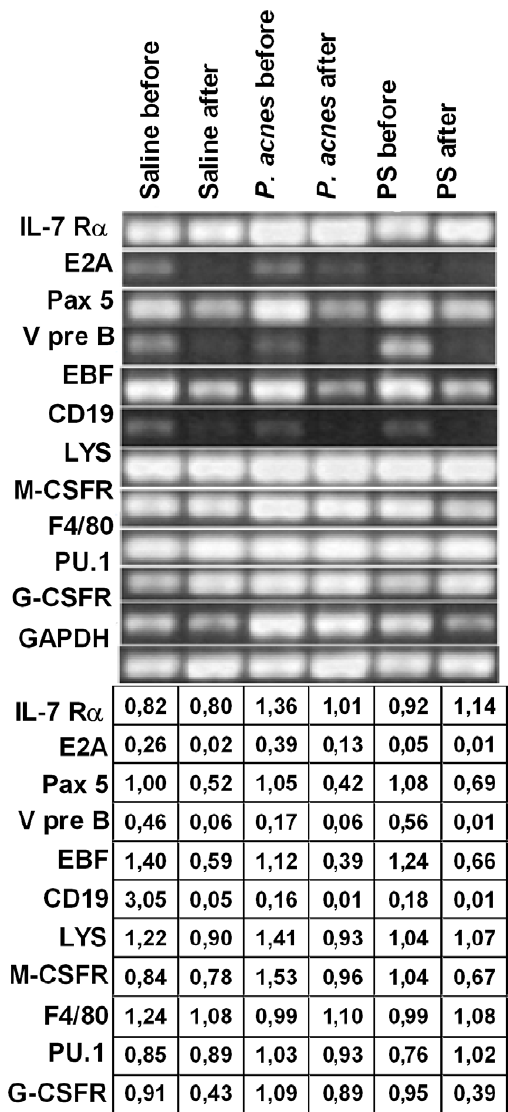
Figure 5. Myeloid and lymphoid gene expression by B-1b- enriched cells and B-1 cell-derived mononuclear phagocytes (B-1CDP). The peritoneal cells from P. acnes -, PS- or saline-treated mice were cultured for 5 days. The non-adherent population (B-1b-enriched cells) was re-cultured for 5 more days for phagocyte differentiation (B- 1CDP). After each of these periods, the lymphoid and myeloid gene expression by B-1b cells (before re-culture) and B-1CDP (after re-culture) was analyzed by reverse transcriptase-polymerase chain reaction (RT- PCR). The PCR products were amplified using primers that detected the indicated transcripts. The PCR products were visualized on agarose gels by ethidium bromide staining. The amount of input cDNA was normalized by analyzing the control GAPDH transcripts. IL-7R a : alpha subunit for interleukin 7 receptor, E2A: E box protein, Pax5: paired box 5, VpreB: surrogate light chain, EBF: early B-cell factor, LYS: Lysozyme; M-CSFR: macrophage colony-stimulating factor receptor, G-CSFR: granulocyte colony-stimulating factor receptor, GAPDH: glyceraldehyde 3-phosphate dehydrogenase.